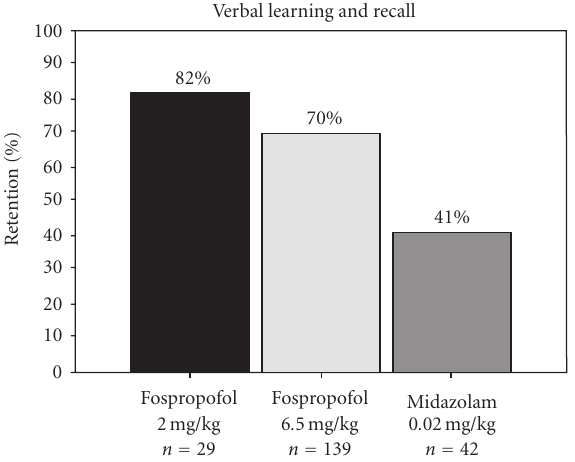
Figure 3: Learning and recall in fospropofol patients (2.0mg/kg versus 6.5mg/kg) with midazolam as